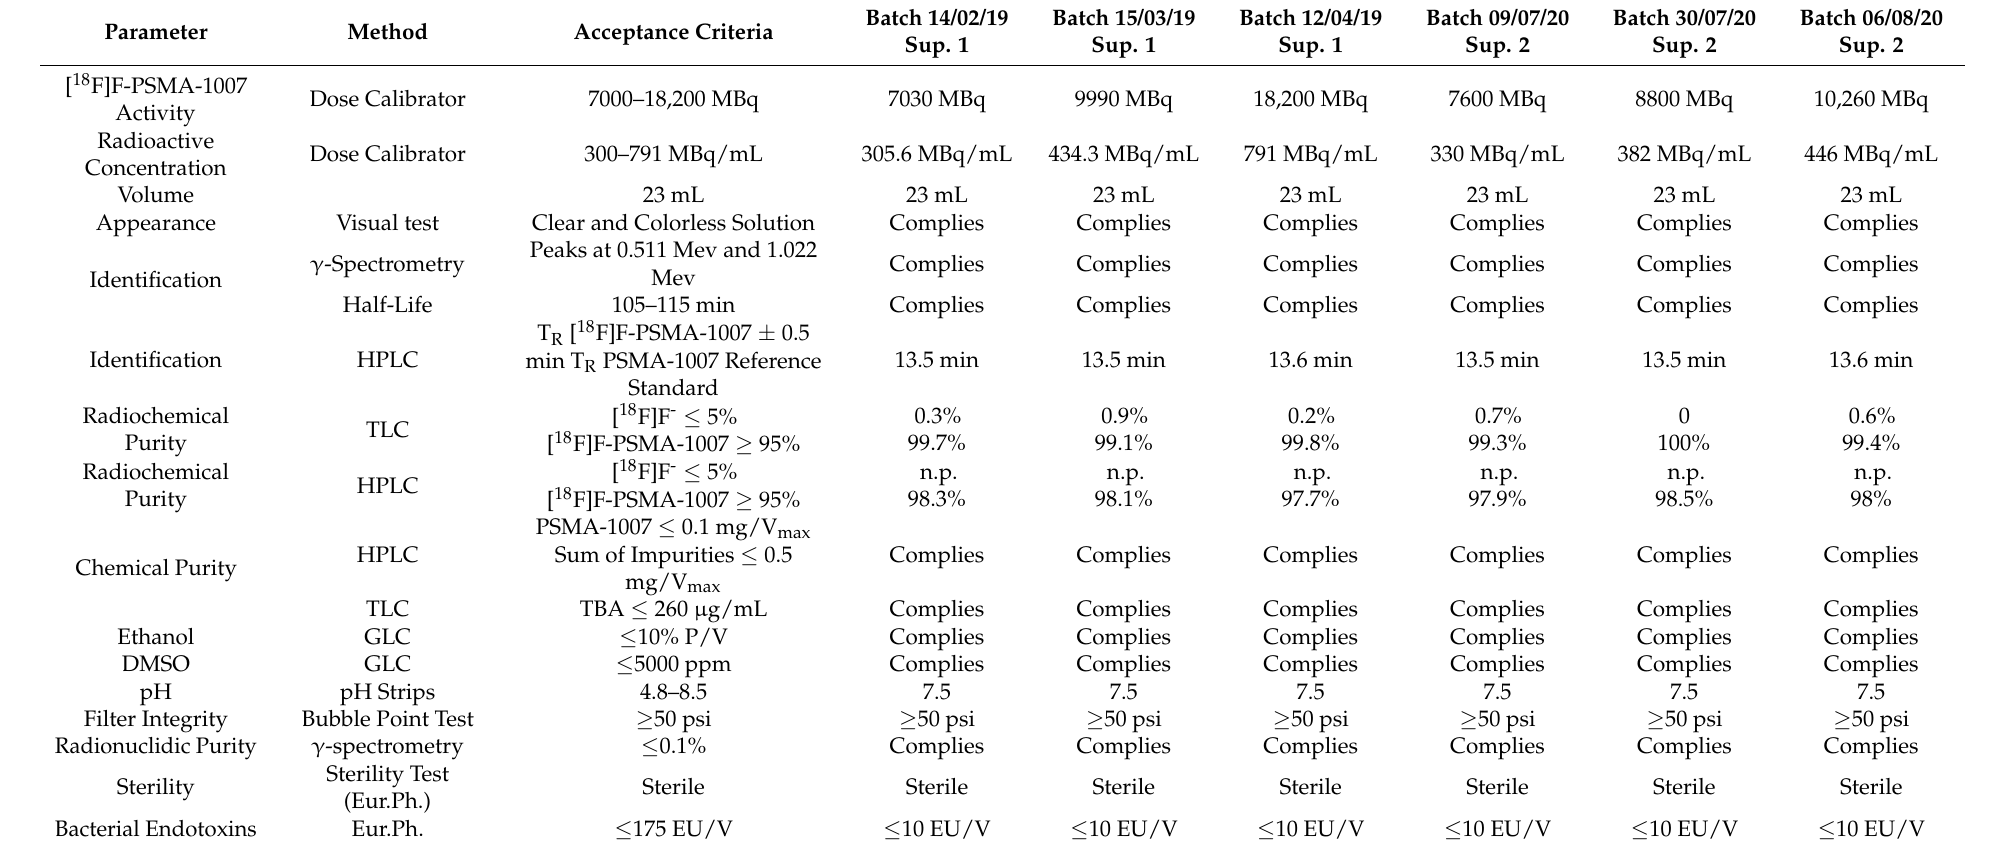
Table 5. Results of [ 18 F]F-PSMA-1007 representative batches obtained with [ 18 F]F - from different